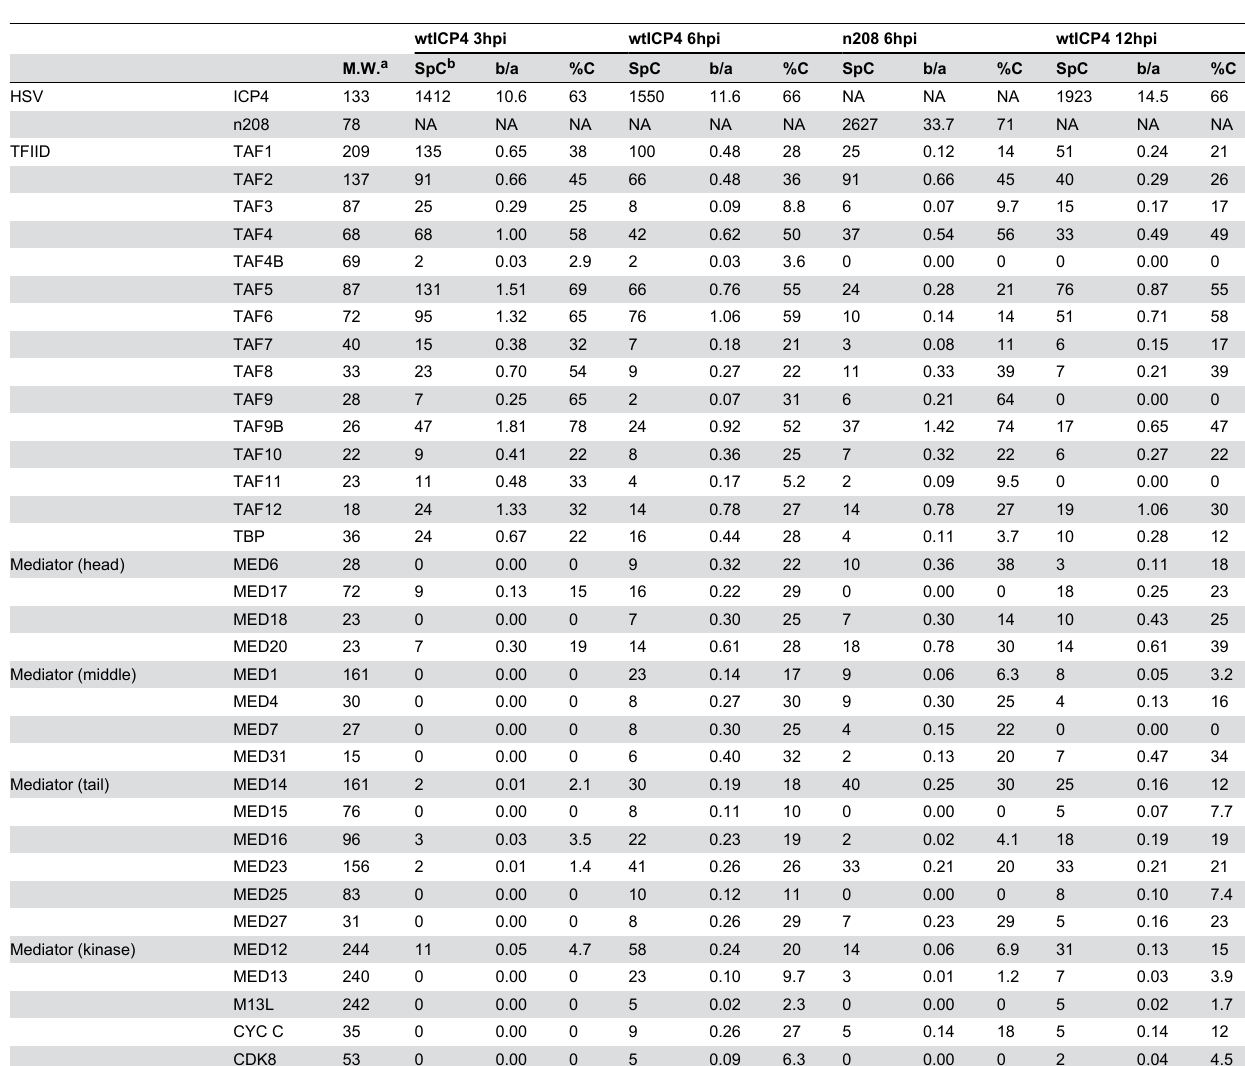
Table 1. TFIID and Mediator components copurifying with